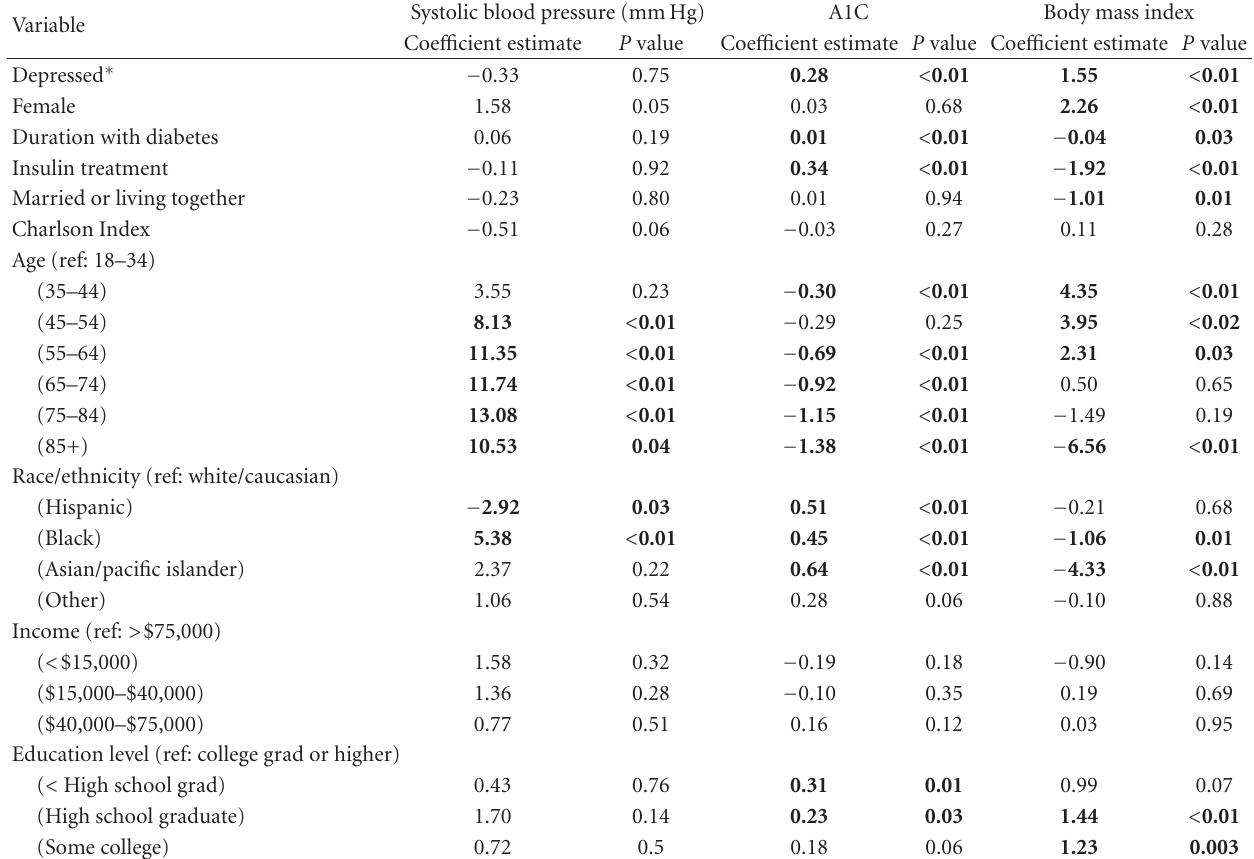
Table 2: Linear regression estimates of the association of cardiovascular risk factors with depression.